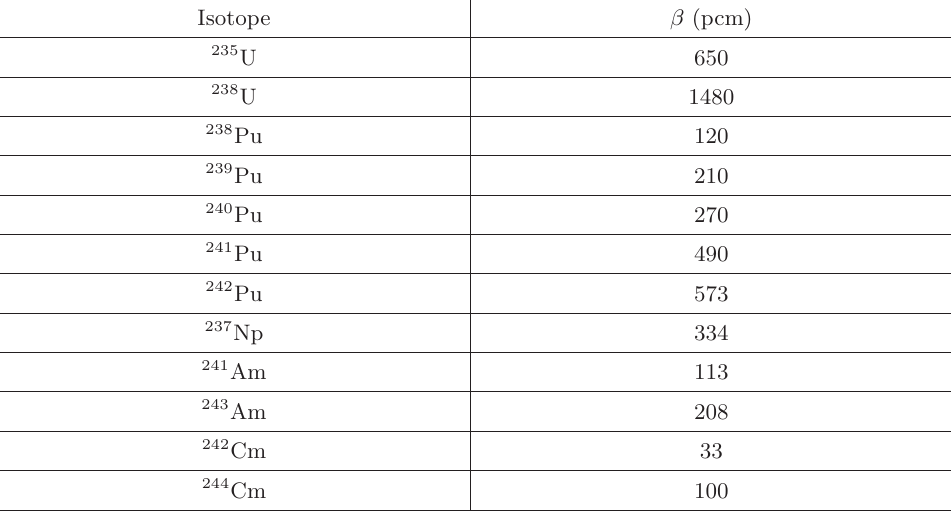
Table I. – Values of delayed neutron fraction β (pcm) for various actinides